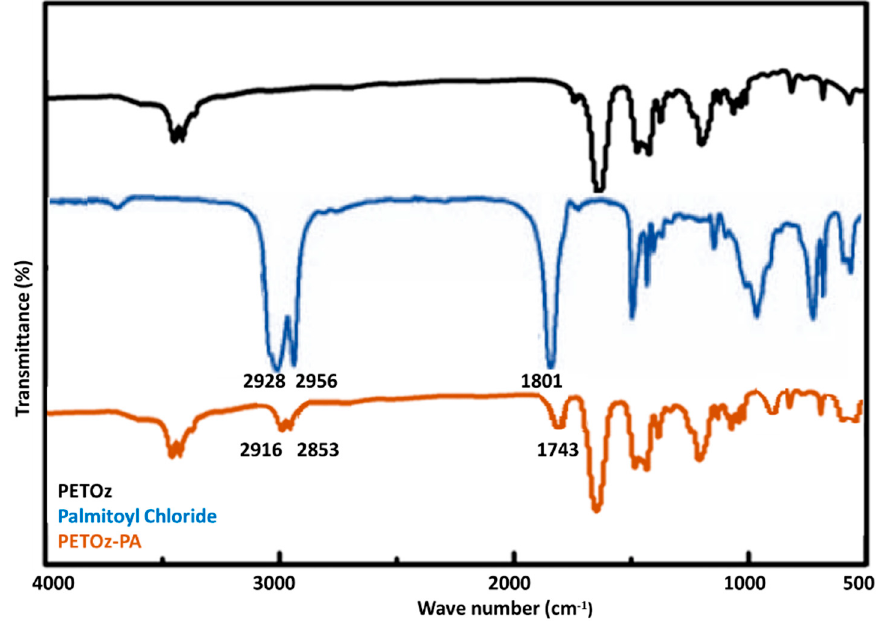
Figure 2. FTIR spectra of PEtOz, palmitoyl chloride, and PETOz-PA. The whole spectra are shown from 4000 to 500 cm − 1